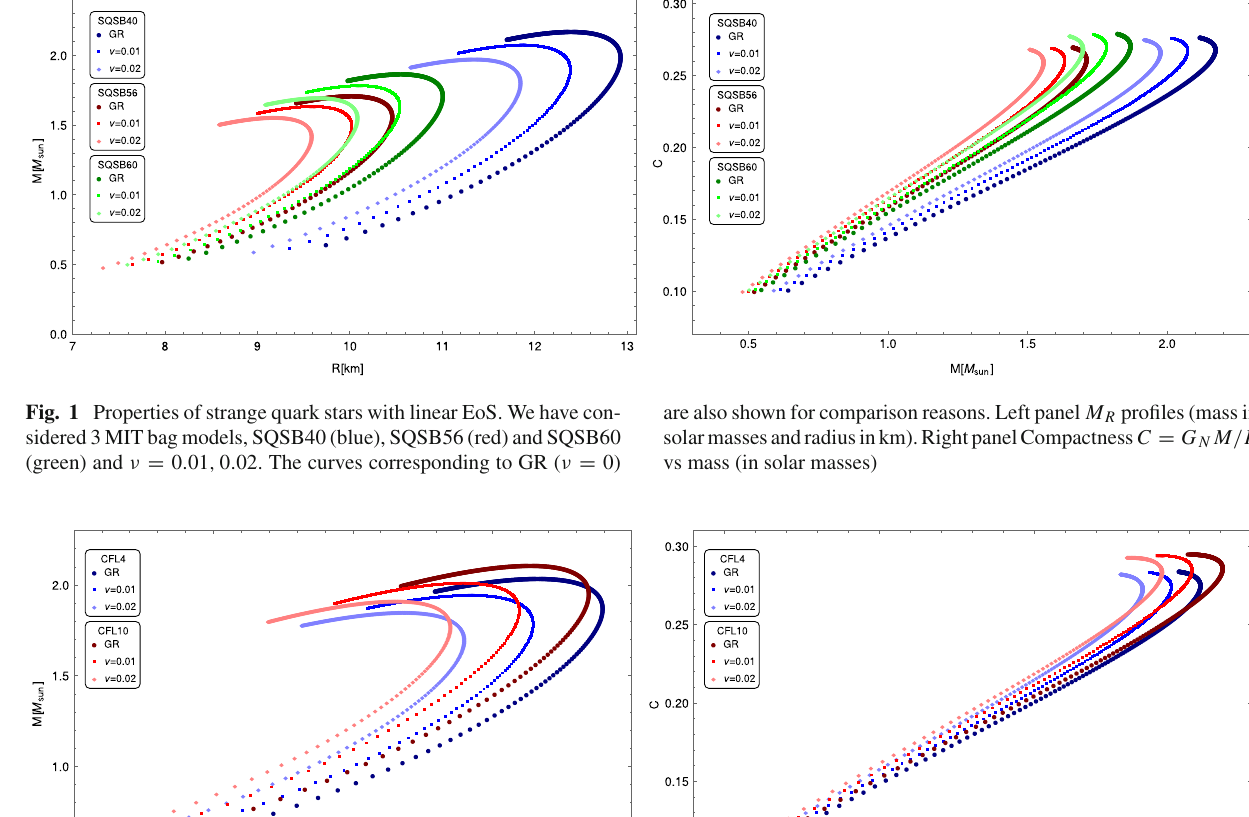
Fig. 2 Propertiesofstrangequarkstarswithanon-linearEoS.Wehave considered 2 CFL models, CFL4 (blue) and CFL10 (red) (see text) and ν = 0 . 01 , 0 . 02.ThecurvescorrespondingtoGR( ν = 0)arealsoshown Fig. 3 Speed of sound, c 2 s = dp / d ρ , vs normalized radial coordinate r / R for ν = 0 . 02 and for the models SQSB56 (blue) and CFL10